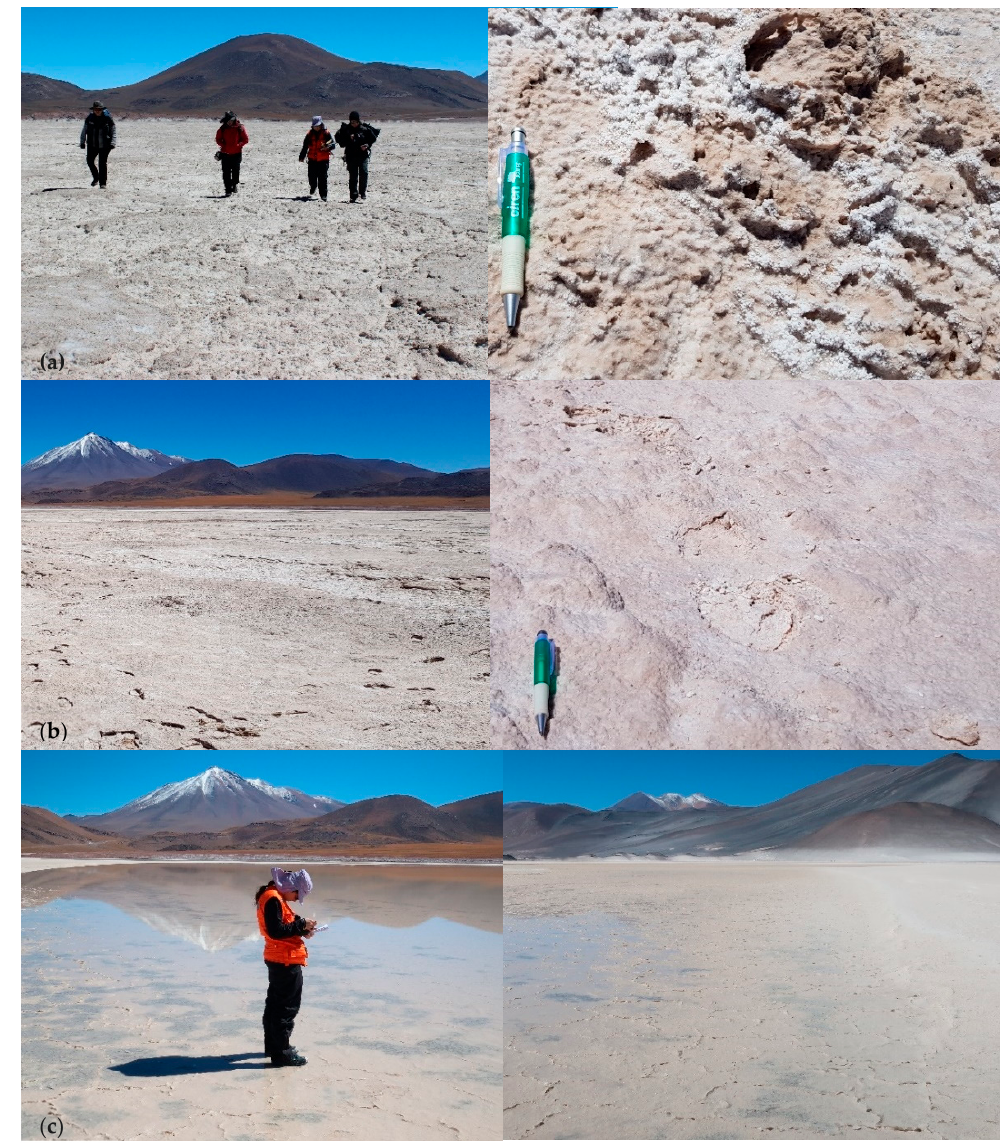
Figure 4. Types of salt crust observed in the field on 3 April 2018. ( a ) Upper panel: Hard-pan crust 1, mixture of salts and sediments (rough surface), ( b ) Center panel: Hard-pan crust 2 (gypsum and halite), ( c ) Bottom panel: Soft pan crust with contents of organic matter and thrust polygons by interaction with water.